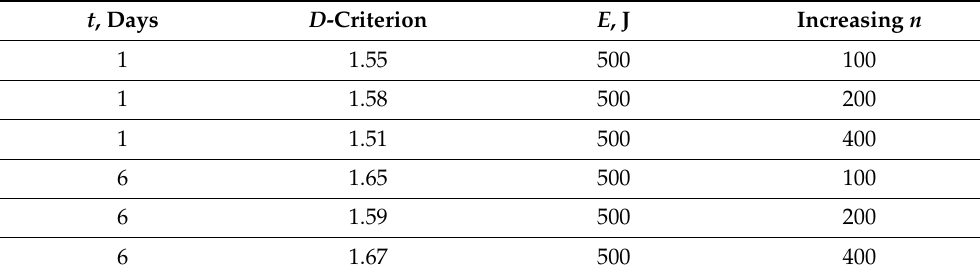
Figure 4. Fibroblasts E = 500 J, t = six days, D = 1.649 ± 0.0104, Sudan IV and hematoxylin-eosin staining, magnification n = 100. Table 2. Criterial assessment of the cell structure